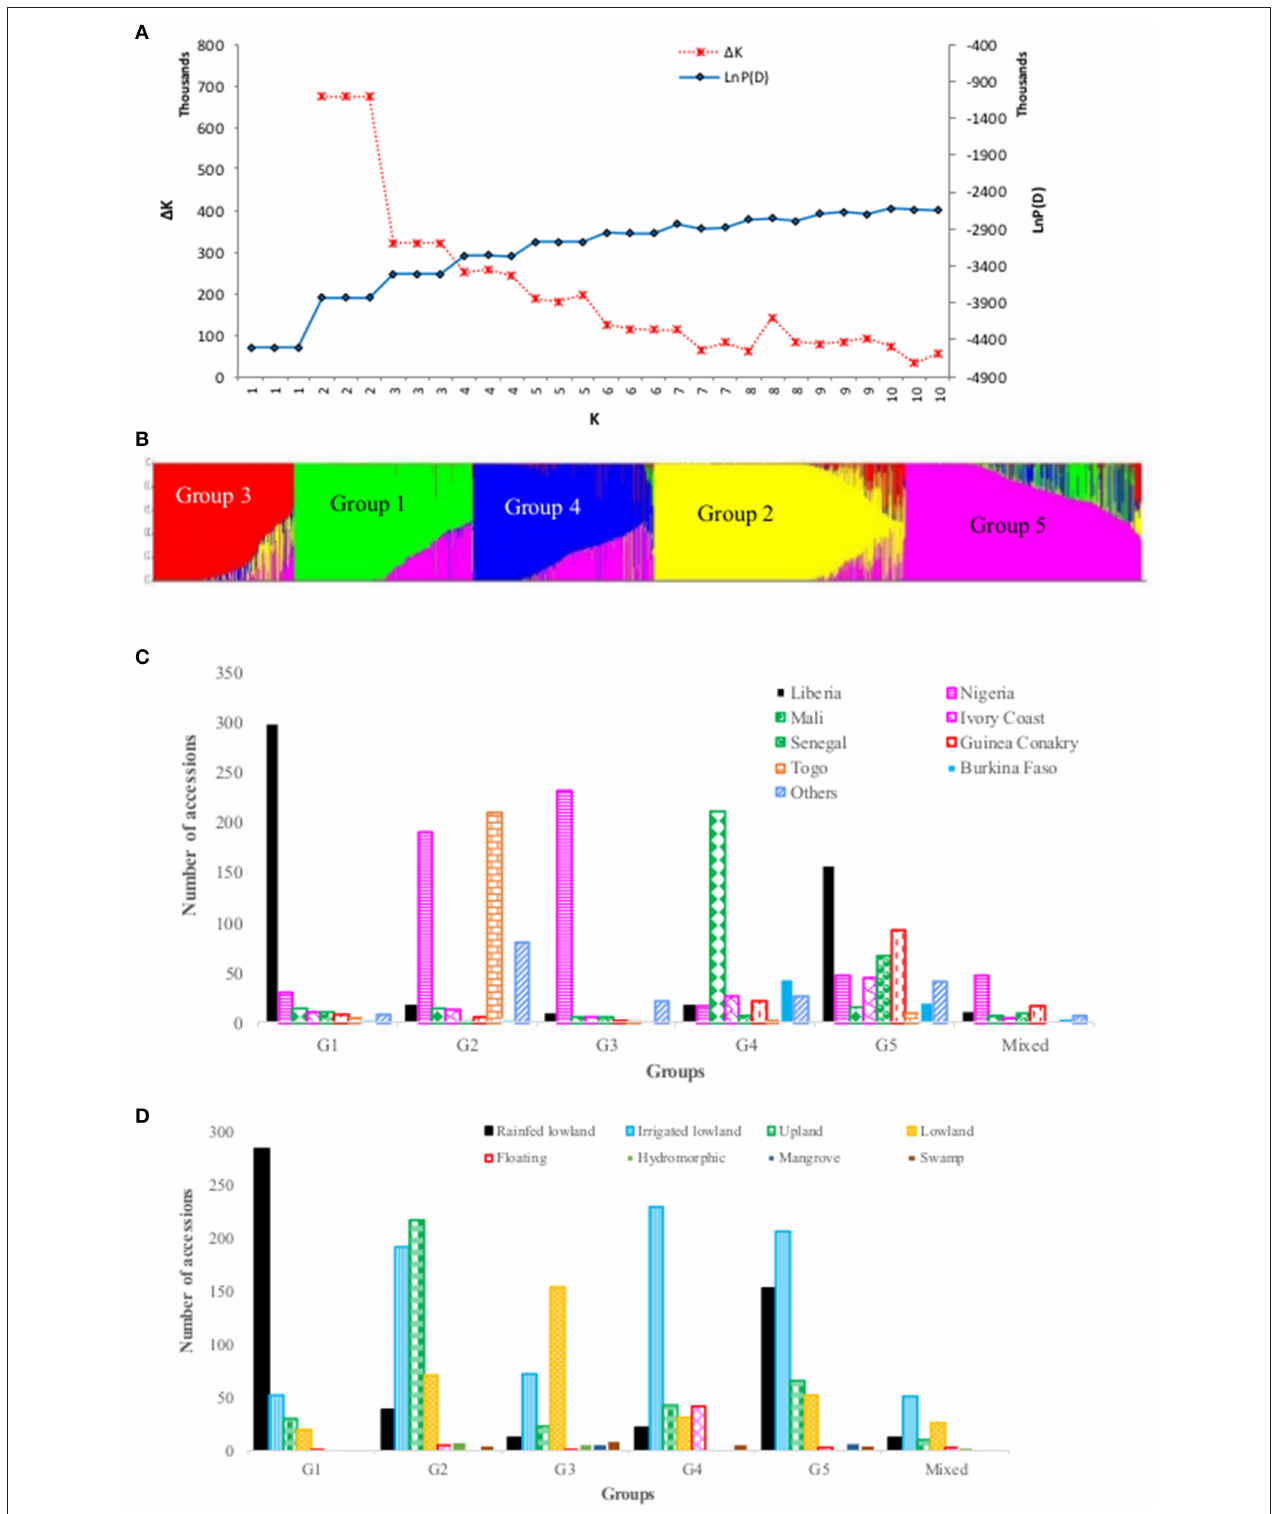
FIGURE 3 | Population structure of 2,179 accessions based on 3,834 polymorphic SNPs: (A) plot of LnP(D) and an ad hoc statistic 1 K calculated for K ranging from 1 to 10, with each K repeated thrice; (B) population structure at K = 5, with each accession represented by a single vertical line that is partitioned into K colored segments, with lengths proportional to the estimated probability membership value (y-axis); (C) frequency distribution of accessions belonging to each predicted